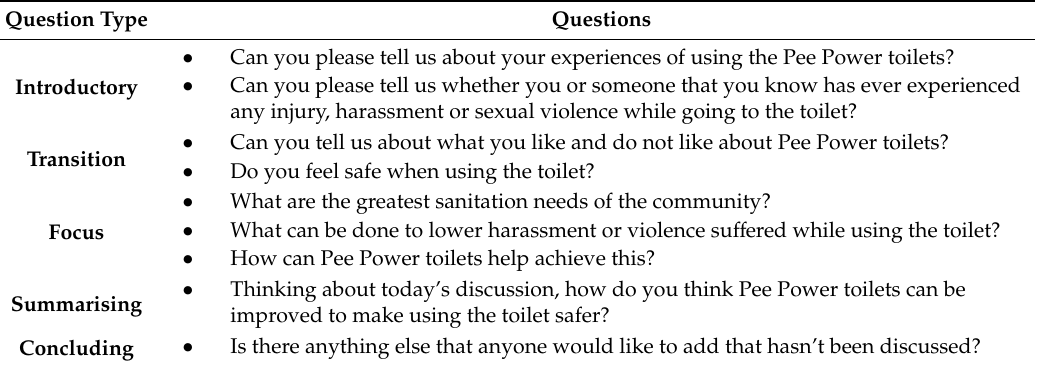
Table 1. Example questions used for focus groups.